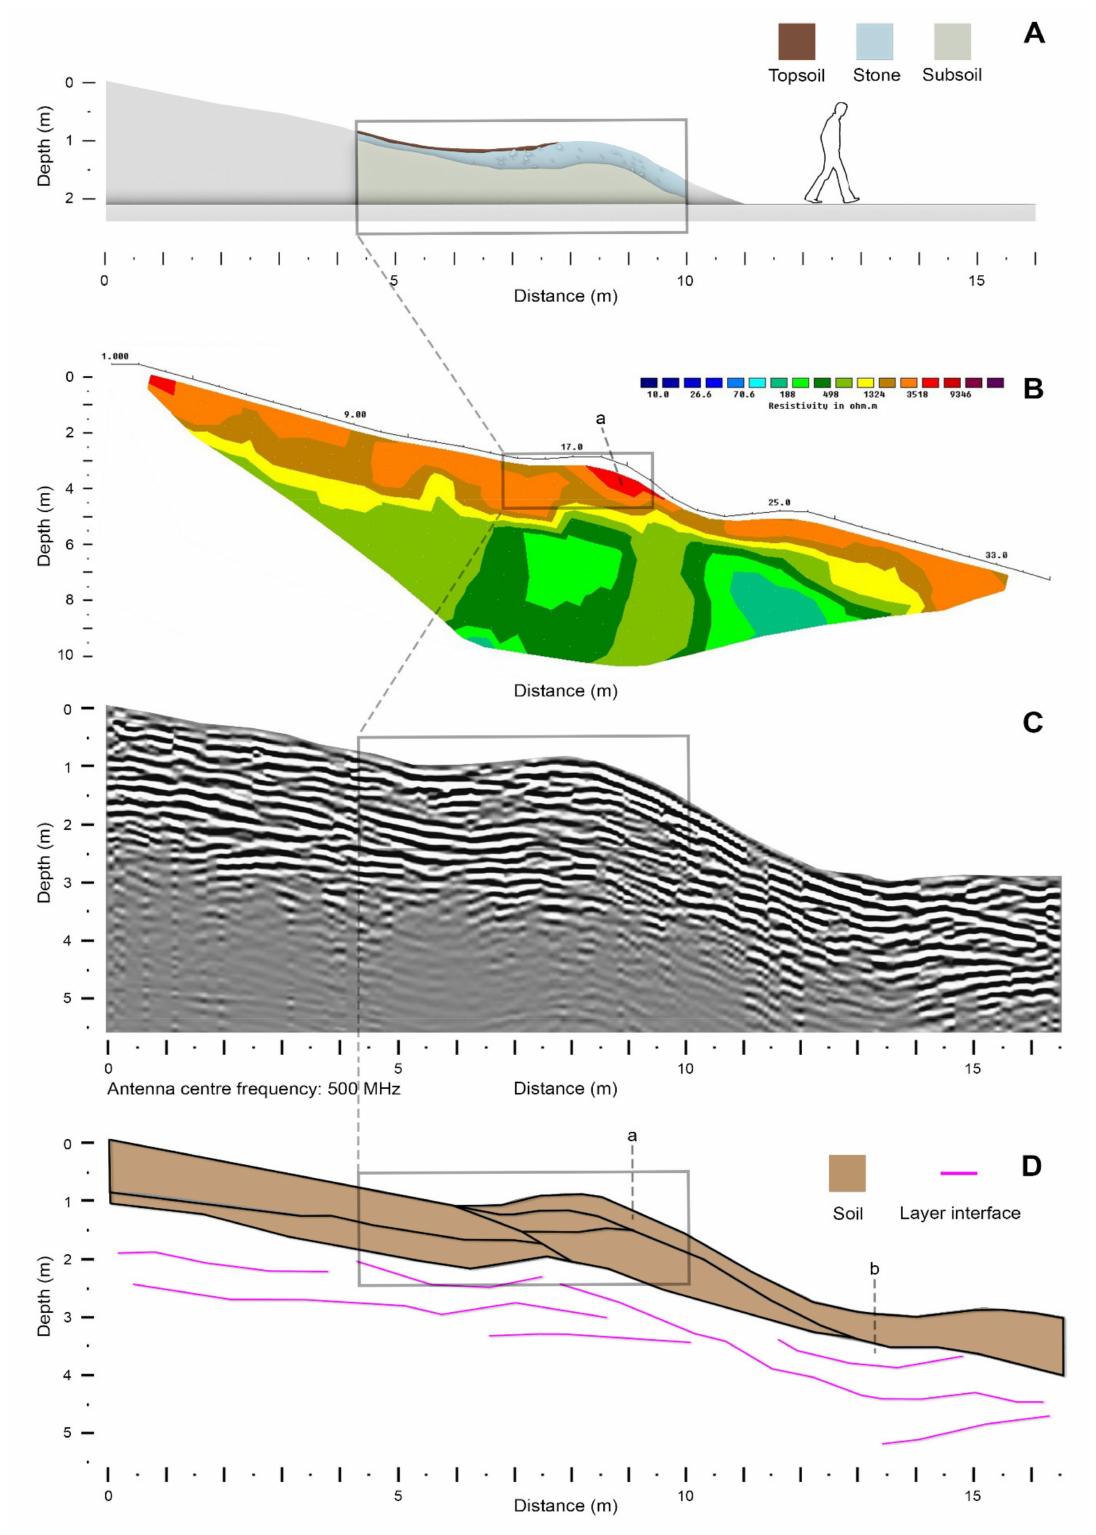
Figure 14. Svät ý Jur-Neštich—bailey II. ( A ): Profile of the hillfort’s fortification based on the results of archaeological excavation ([15], Figure 11). ( B ): Electrical resistivity tomography model in Schlum- berger configuration. ( C ): GPR vertical time/depth radarogram from an antenna with 500 MHz centre frequency. ( D ): Interpretation of the GPR